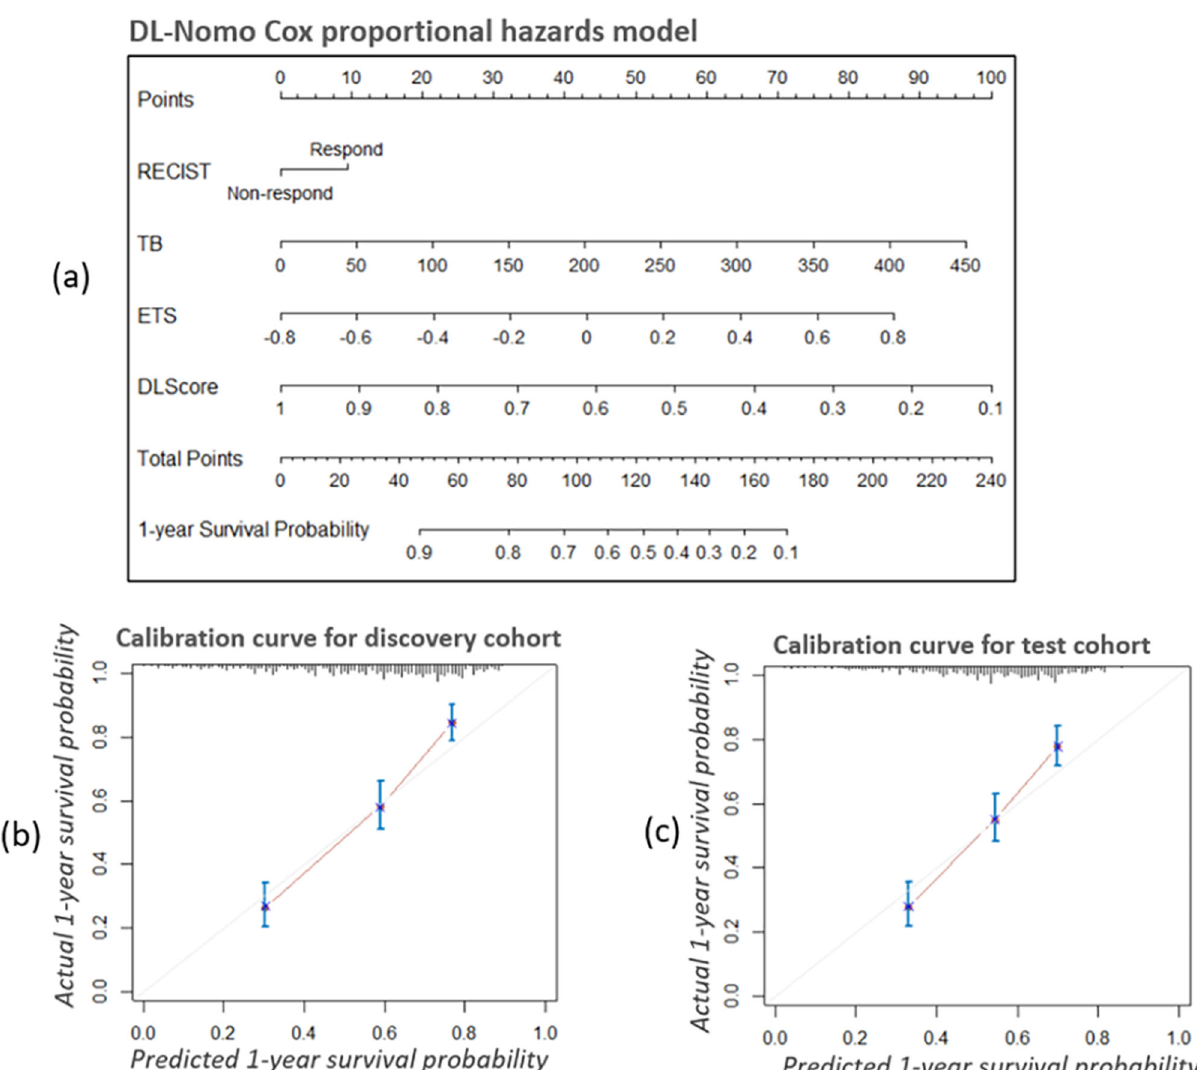
Fig. 4 The nomogram for the DL-Nomo model with the assessment of its calibration. a The nomogram for the DL-Nomo model. To use the nomogram, fi rstly, locate the patient ’ s DL prediction score on the DLScore axis. Then, draw a line straight upward to the points axis to determine how many points toward the 1-year survival probability that the patient is received according to his or her DL prediction score. Repeat the same process for each variate. Thirdly, sum the points received from each of the variates and locate the fi nal sum on the total point axis. Finally, draw a line straight down from the total point axis to the 1-year survival probability axis to fi nd the patient ’ s fi nal 1-year survival probability. b , c The calibration curves for the DL-Nomo model in the discovery ( n = 502) and test cohorts ( n = 526), respectively. The calibration curve shows the calibration in terms of the agreement between the predicted and observed 1-year survival probability. Model-predicted 1-year survival probability is plotted on the x -axis, while the observed actual 1-year survival probability is plotted on the y -axis. The diagonal gray line indicates a perfect prediction by an ideal model, in which the predicted outcome perfectly corresponds to the actual outcome. The red lines indicate the performance of the model, a closer lining of which with the diagonal gray line represents a better estimation. And the predicted survival probability for the three patient groups (The short, median, and long survival groups with patients of n = total patients/3 in each group) were shown as error bars, i.e., mean value ± standard